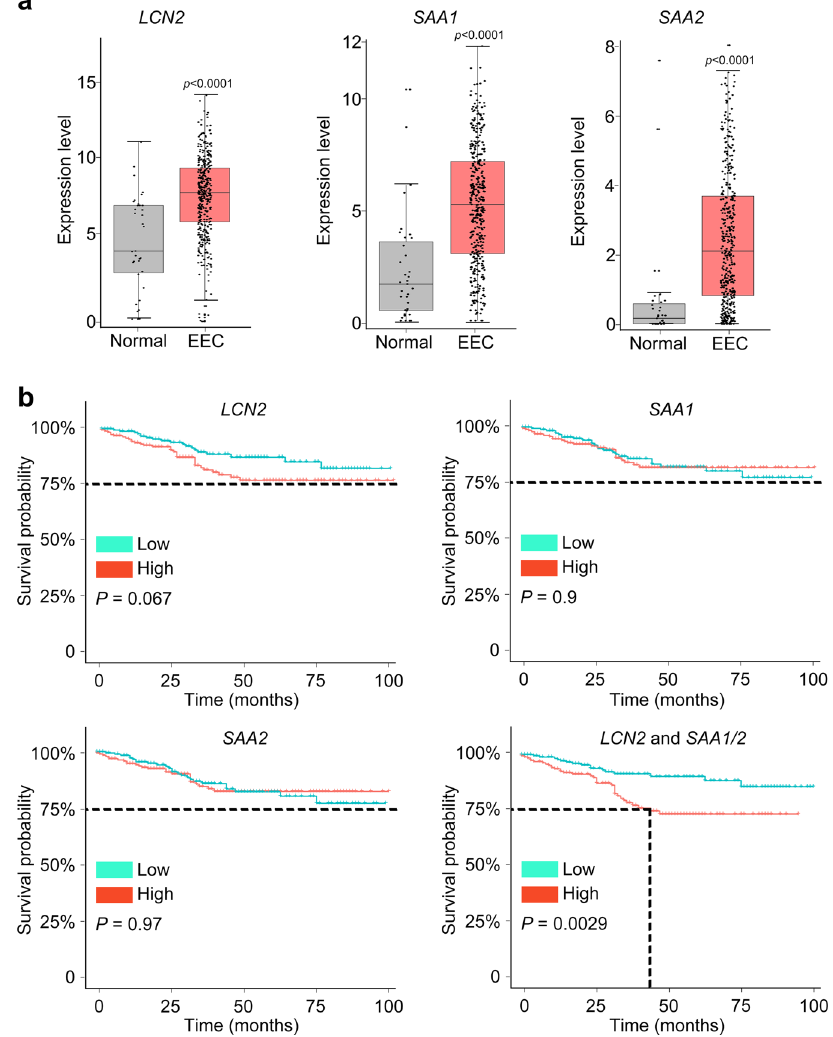
Fig. 5 | Oncogenic subpopulation has implications for EEC patients' survival. a According to the TCGA EEC data, the expression of LCN2 , SAA1 , and SAA2 was signi fi cantlyelevatedinEECsubjects( t test,two-sided, p valuesarenoted).Normal samples: n =35,EECsamples: n =411.Theexpressionlevelofeachgeneisvisualized by log 2 (TPM+1). Bar plots show the median (center), 25 – 75 percentile (box), and lowerwhisker=smallestobservationgreaterthanorequaltolowerhinge − 1.5*IQR